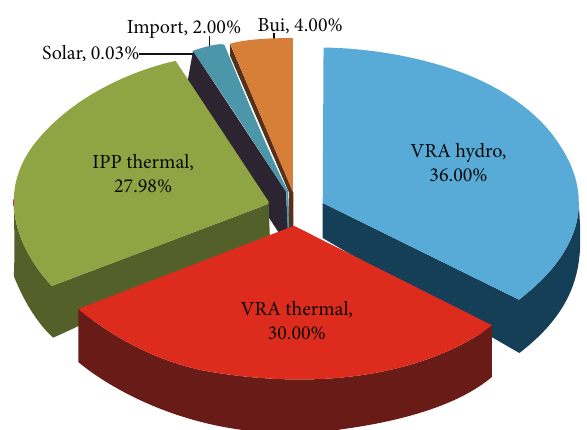
Figure 1: Energy supply by sources for the year 2017 (source: